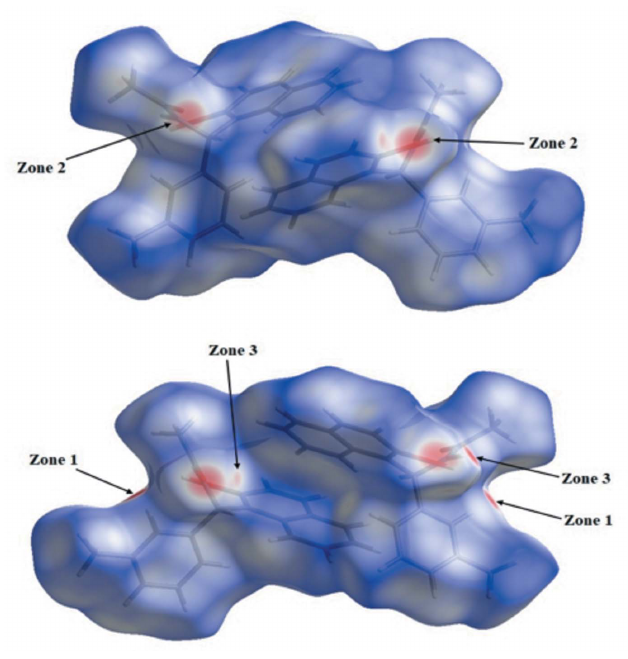
Figure 5 Two-dimensional fingerprint plots: ( a ) overall, and delineated